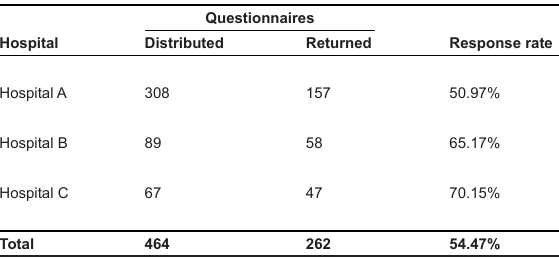
TABLE 1 Response rate from individual